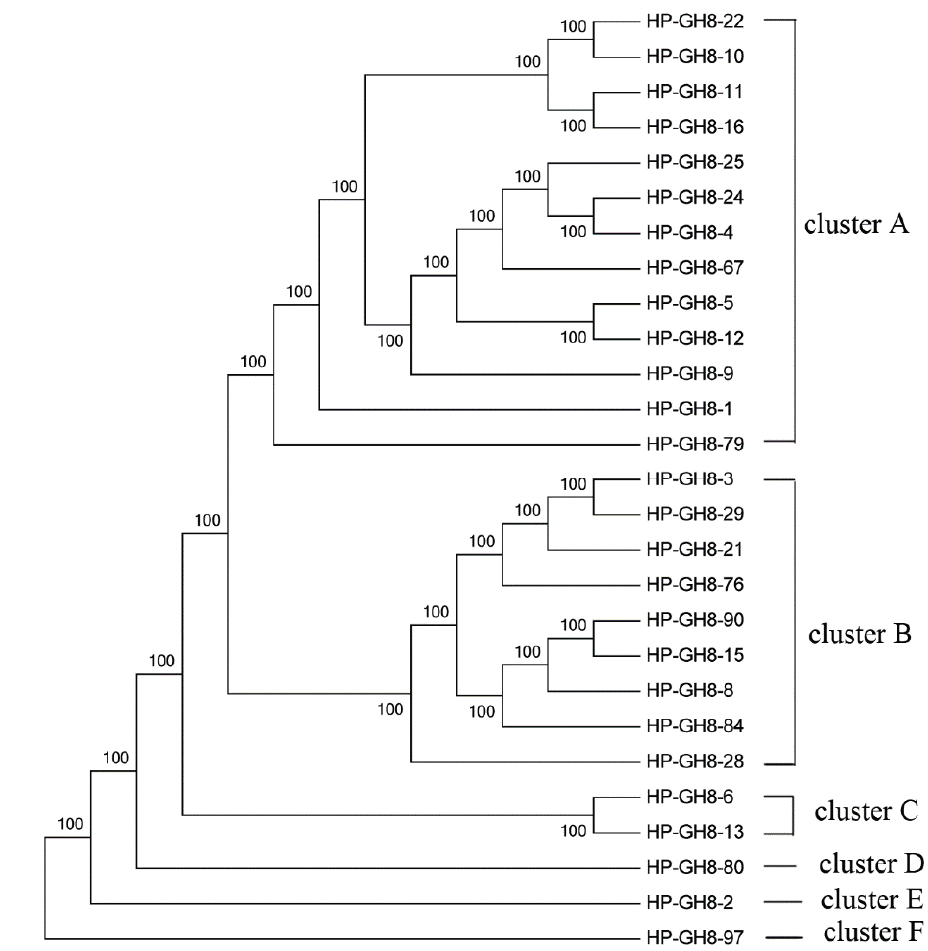
Figure 3. Maximum Likelihood phylogenetic tree of the GH8 amino acid